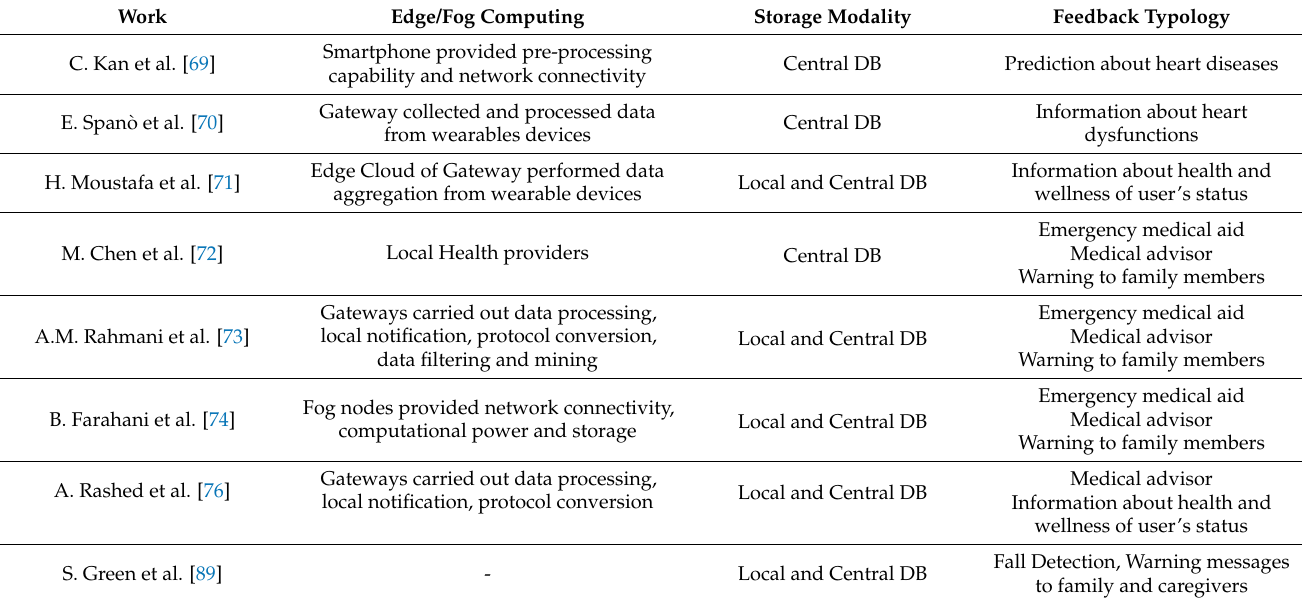
Table 1. Summary of the scientific works previously discussed from the point of view of the availability of a fog/edge layer, the storage modality, and the typology of provided